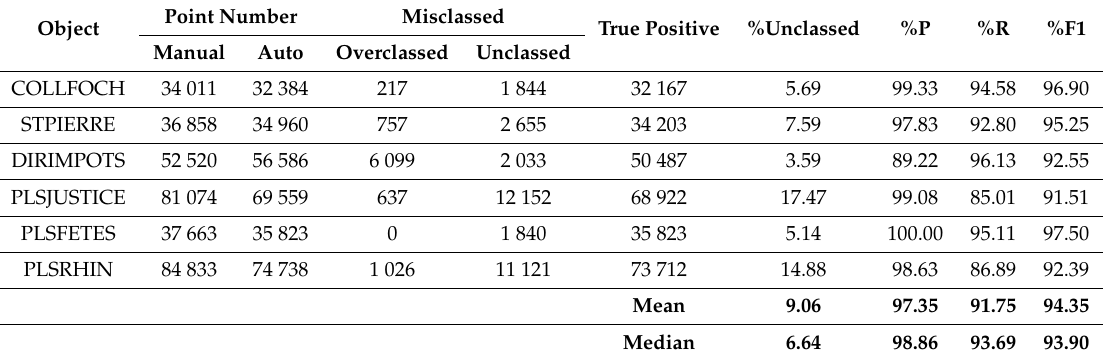
Table 2. The quantitative analysis on the results of step 1 for St-Pierre. In this table, only one class was taken into account (public buildings) with a total of 6 out of 17 objects used in the statistical analysis. %P is precision, %R is recall, and %F1 is the normalized F1